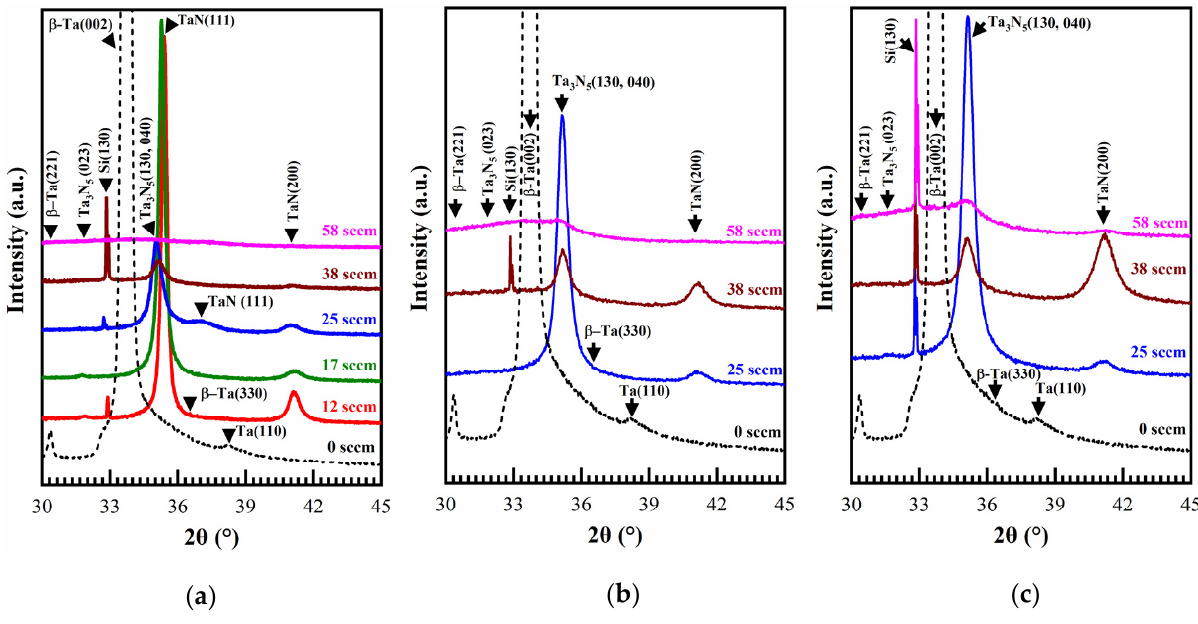
Figure 3. XRD patterns of Ta (20 min) and TaN films deposited for ( a ) 10 min, ( b ) 20 min, and ( c ) 30 min with different N 2